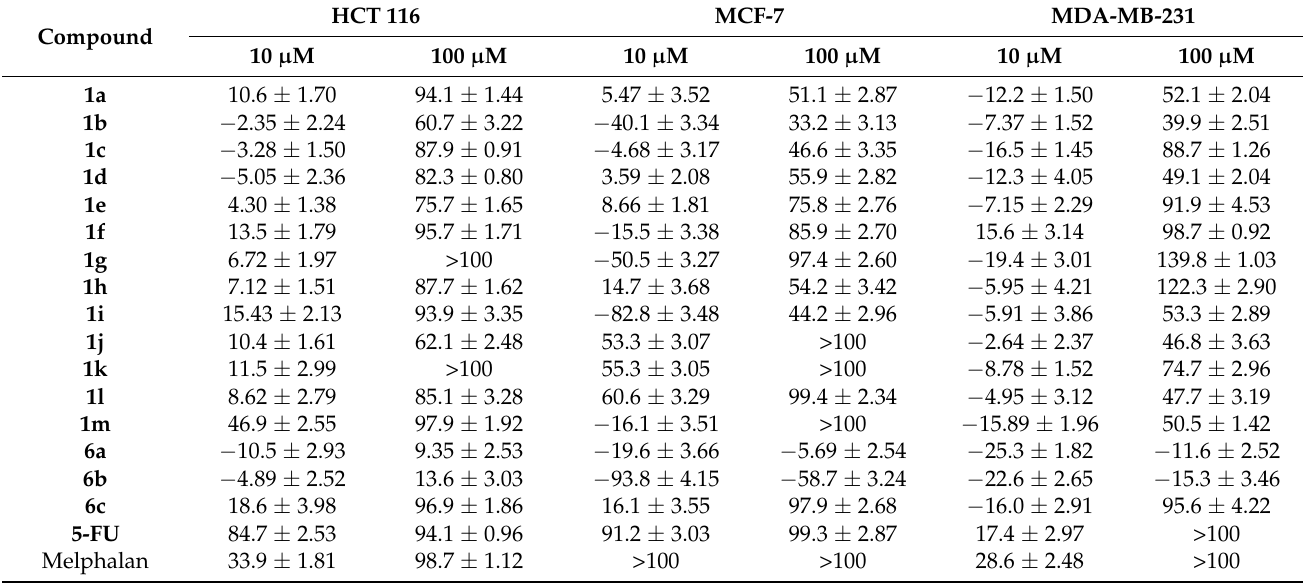
Table 1. The percentage inhibition of HCT 116, MCF-7, and MDA-MB-231 cells by 1a–m and 6a–c.